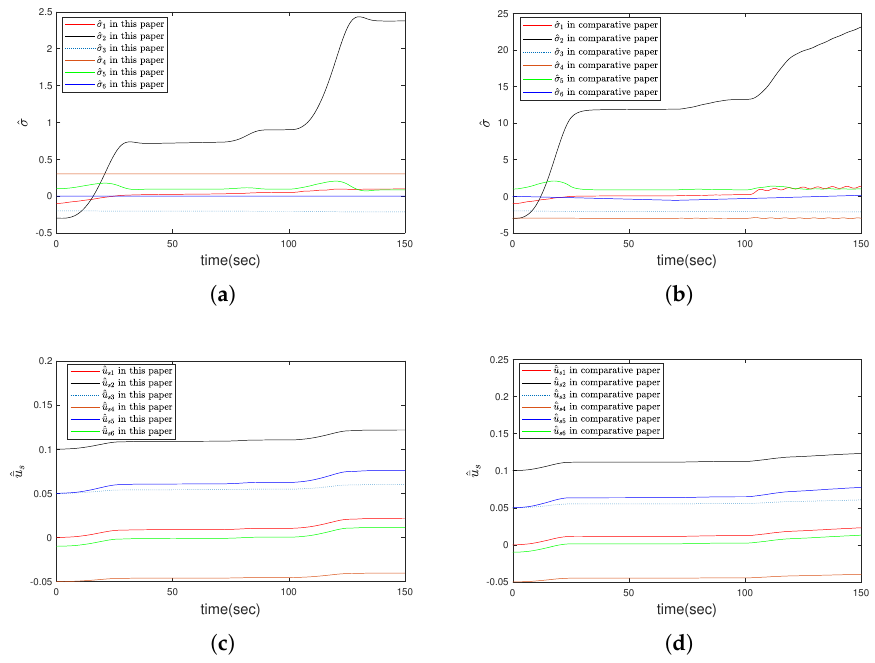
Figure 9. ( a , c ) The estimation curves of unknown parameter σ , ¯ u s in this paper. ( b , d ) The contrastive curves of unknown parameter σ , ¯ u s in method that ignores the effect of thruster saturation in [15].